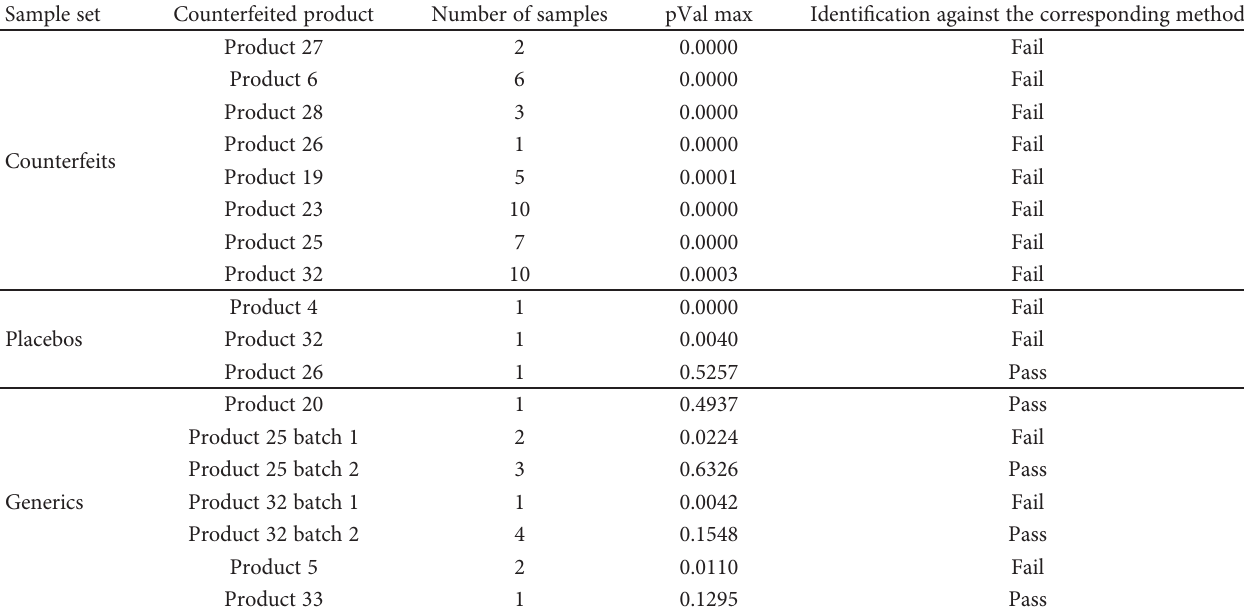
Table 2: Second validation results obtained with the challenging samples. The number of samples measured for each product has been added. The maximum p values (pVal) obtained for each counterfeit are presented in the table together with the corresponding pass/fail result. Sample